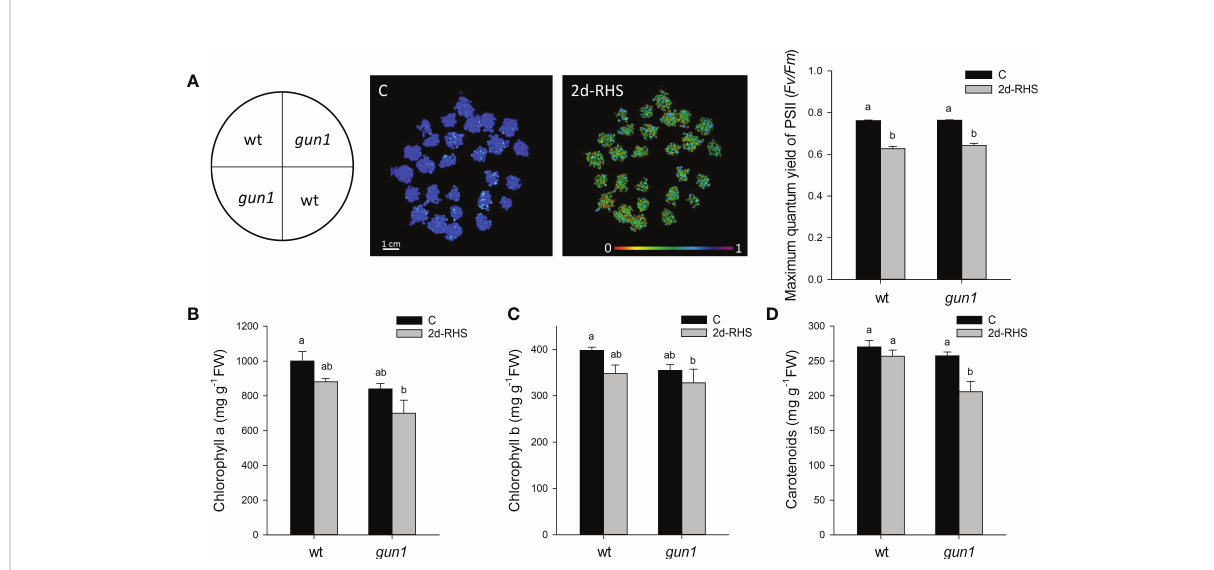
FIGURE 2 Photosynthetic parameters of 17 days-old wt and gun1 plantlets, grown at control temperature (C) or subjected, after 15 days of growth, to Heat Stress (HS; 2 hours at 45°C), followed by long-term recovery (2d-RHS; 2 days at 22°C). (A) Photosynthetic performance of wt and gun1 . The maximum quantum yield of PSII ( Fv/Fm ) was measured by using the IMAGING PAM (WALZ). (B) Chlorophyll a, (C) chlorophyll b and (D) carotenoids contents were as well determined. The values are the means ± standard errors of fi ve independent experiments. Different letters indicate signi fi cant differences obtained by one-way ANOVA test (P<